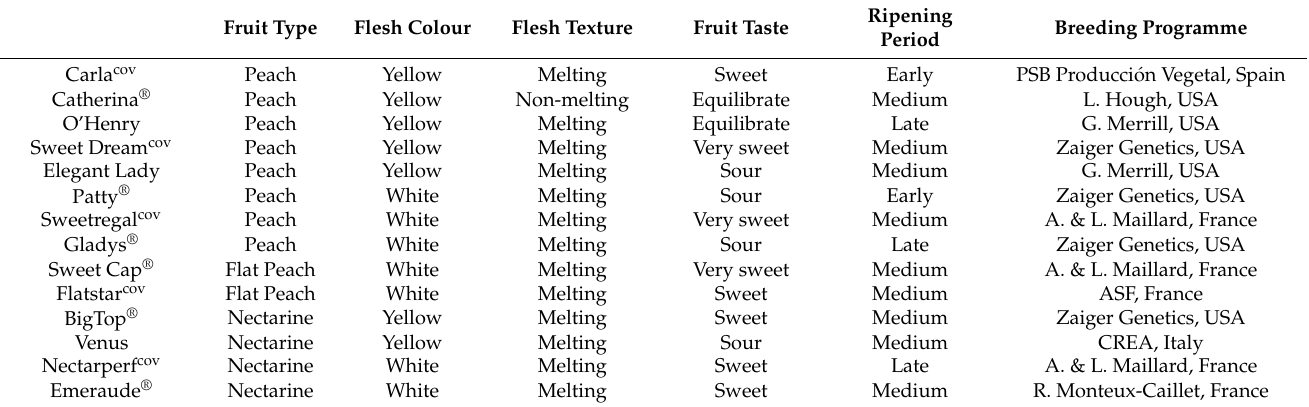
Table 1. List of the 14 cultivars evaluated, along with their main fruit characteristics, ripening period, and breeding program.